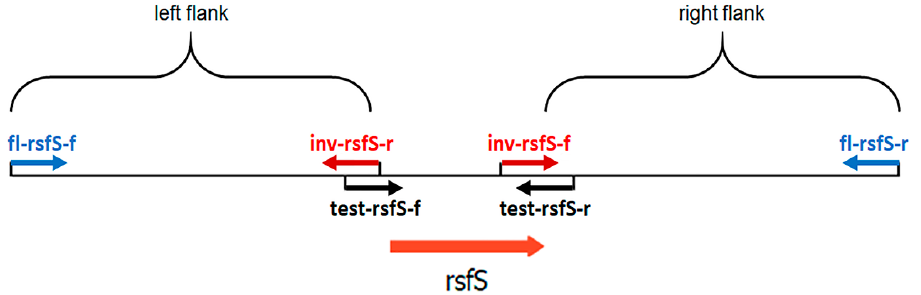
Figure 1. The layout of primers used in this study. fl-rsfS-f/fl-rsfS-f (blue). fl-rsfS fragments primers and inv-rsfS-f/inv-rsfS-r (red), the primers for pUC19 synthesis. fl ∆ rsfS, and test-rsfS-f/test-rsfS-r (black), the primers for test PCR. Arrows indicate the direction of nucleotide chain synthesis.